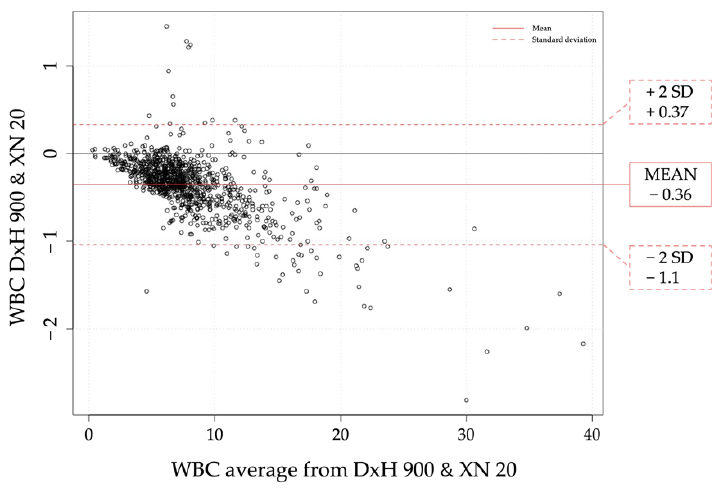
Figure 1. Bland Altman plot comparing WBC in both analyzers. Results from the two analyzers are plotted against the median of the two techniques. Solid point line is related to the mean of the results; hollow point line is related to positive and negative standard deviation.